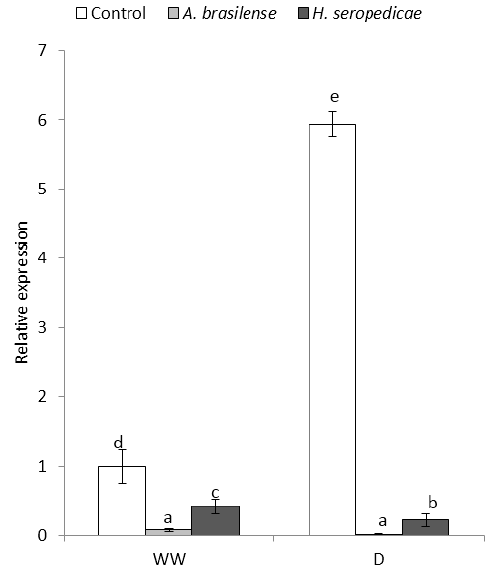
Figure 9. Relative expression of the ZmVP14 gene 20 DAS. Data are shown as means ( n = 5). Means with common letters are not significantly different ( p > 0.05). The plants were cultivated under WW or D conditions. The inoculation * drought interaction p < 0.0001.